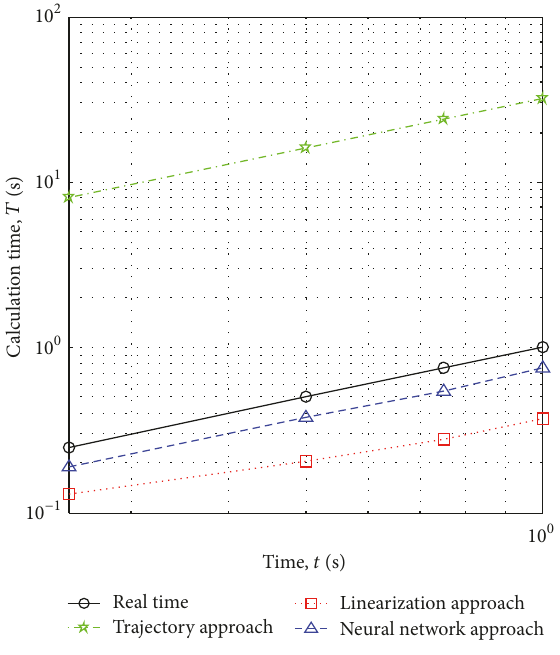
Figure 4: Calculation